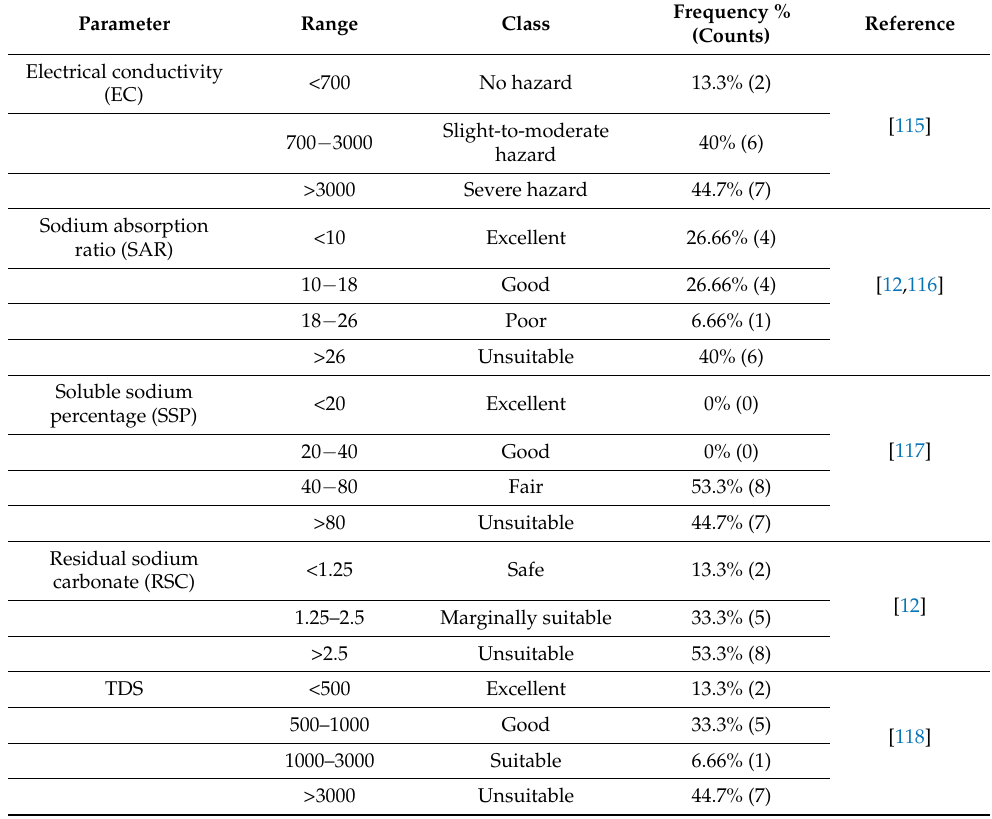
Figure 9. Water quality index map of the groundwater for drinking purposes. Table 4. Suitability of the groundwater for irrigation